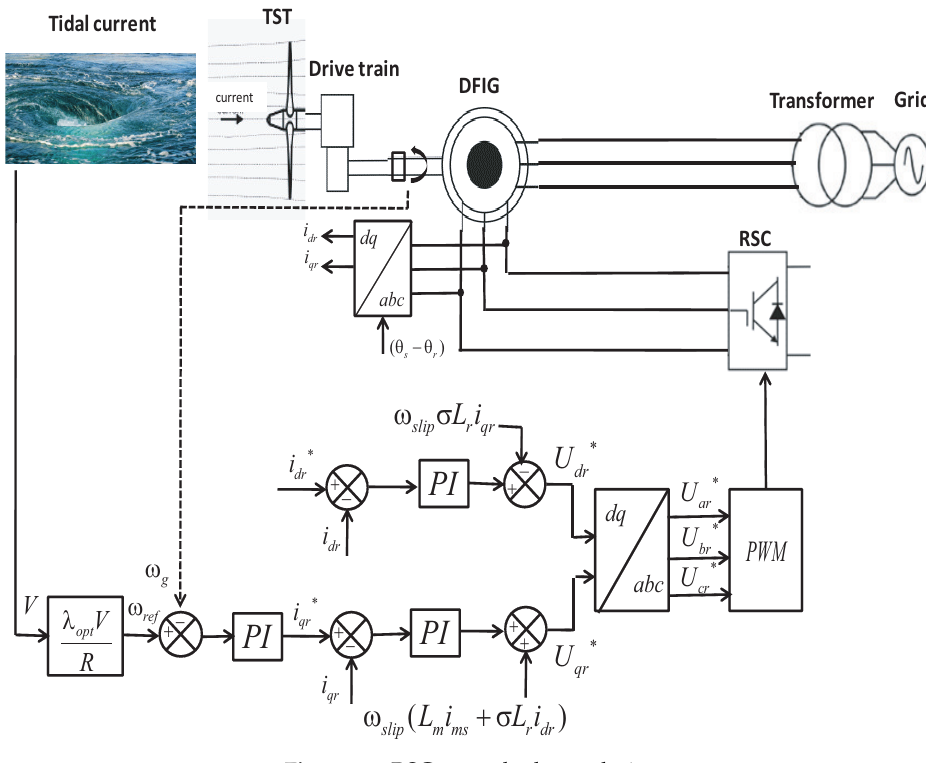
Figure 12. RSC control scheme